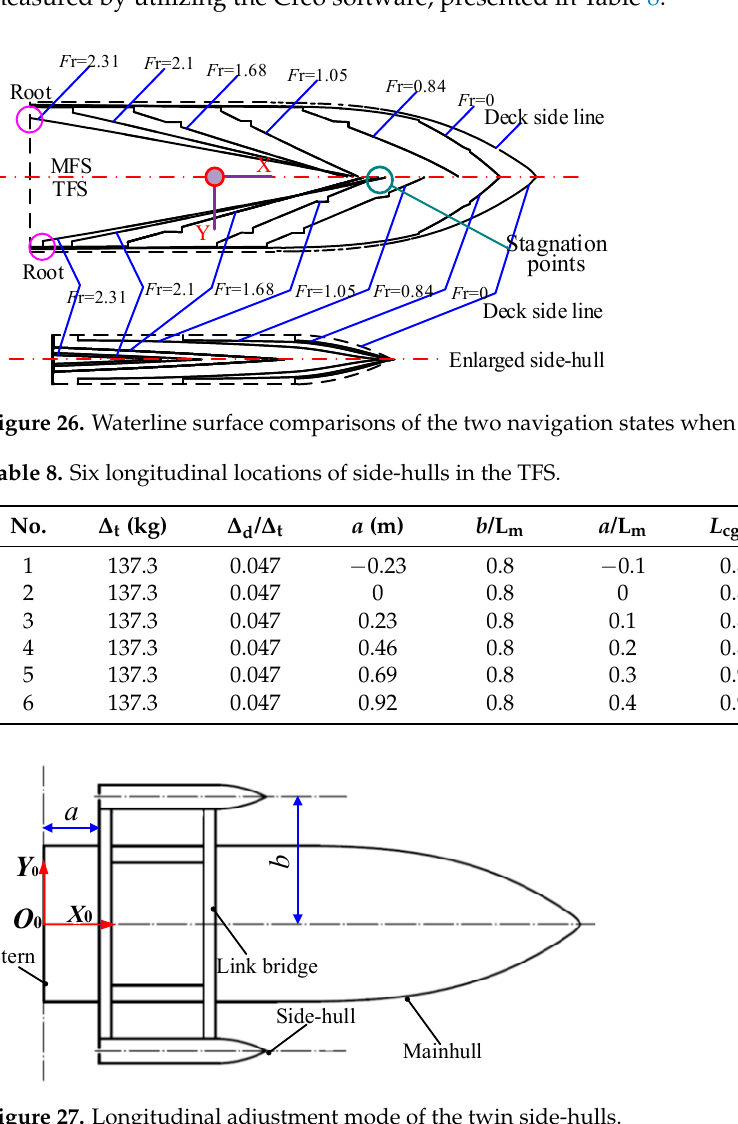
( b ) Figure 28. Different ( a ) longitudinal locations; ( b ) vertical locations of the side ‐ hulls in the TFS. Table 8. Six longitudinal locations of side ‐ hulls in the TFS. No.